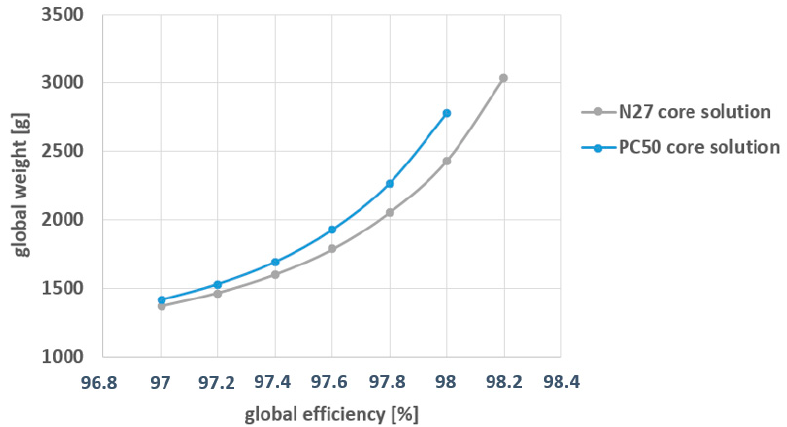
Figure 22. Pareto fronts with two ferrite core materials.